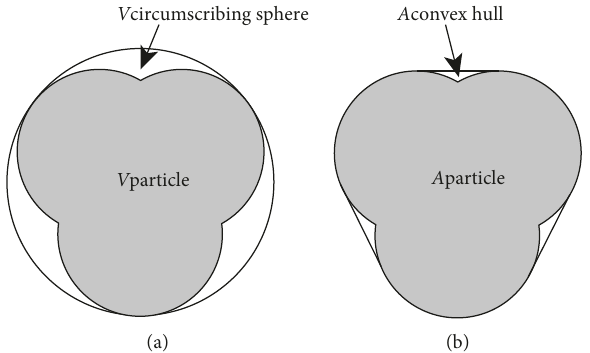
Figure 6: Schematic diagram for the definition of two shape factors. (a) Calculation of sphericity. (b) Calculation of convexity.